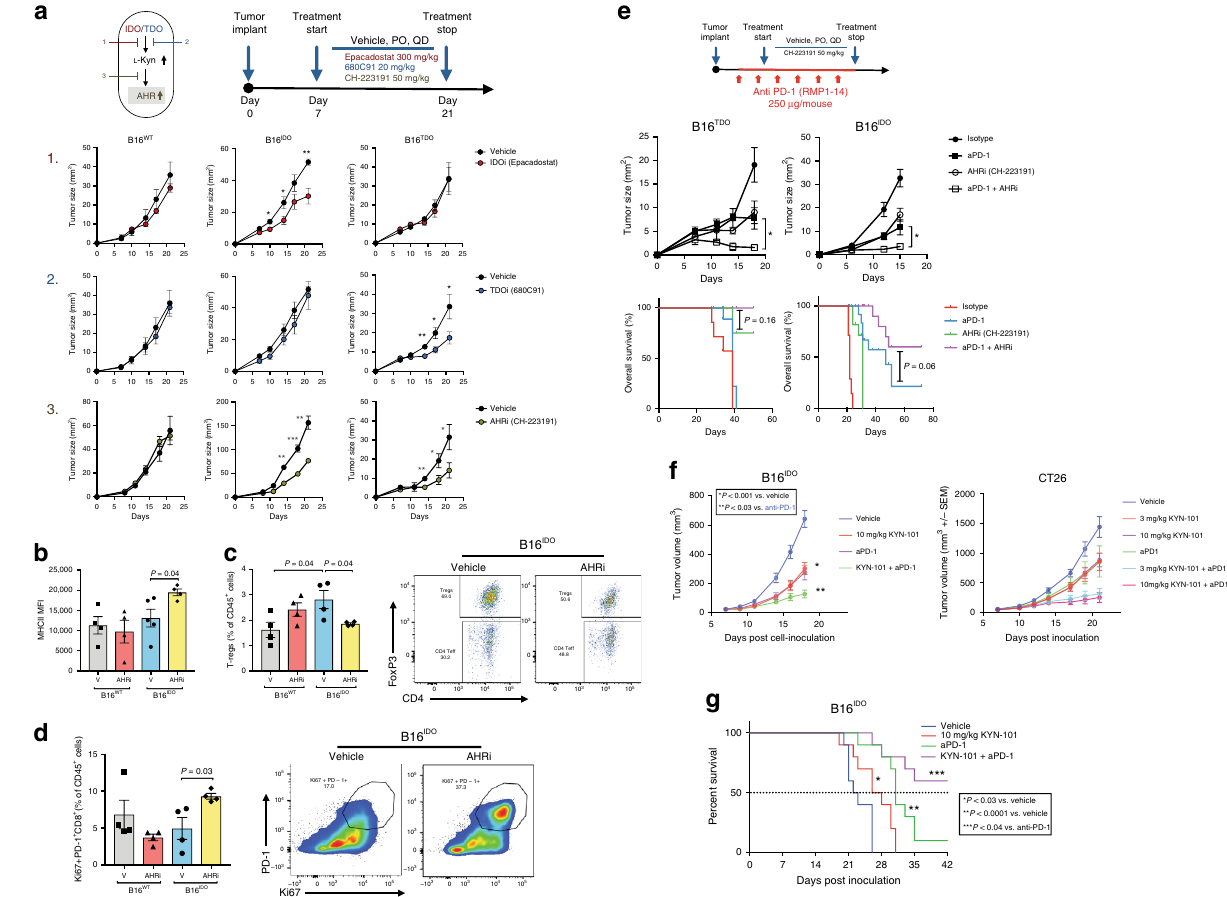
Fig. 4 Selective AHR inhibition reverses IDO/TDO-mediated tumor progression and improves the ef fi cacy of PD-1 blockade. a Top left: scheme fi gure with experimental approach of targeting multiple steps of Trp-catabolic pathway. Top right: therapy regimen (PO, QD). Bottom: tumor progression of orthotopically injected B16 WT , B16 IDO and B16 TDO tumors in mice treated with vehicle or inhibitors (Epacadostat/IDO inhibitor 300 mg/kg/d, 680C91/ TDO inhibitor 20 mg/kg/d, CH-223191/AHR inhibitor 50 mg/kg/d). ( n = 5 mice per group for two independent experiments). b FACS analysis of MHCII expression ( n = 4 per group, n = 5 B16 IDO vehicle). c Quanti fi cation of frequency and representative plots of intratumor Tregs (CD4 + FoxP3 + CD25 + /%